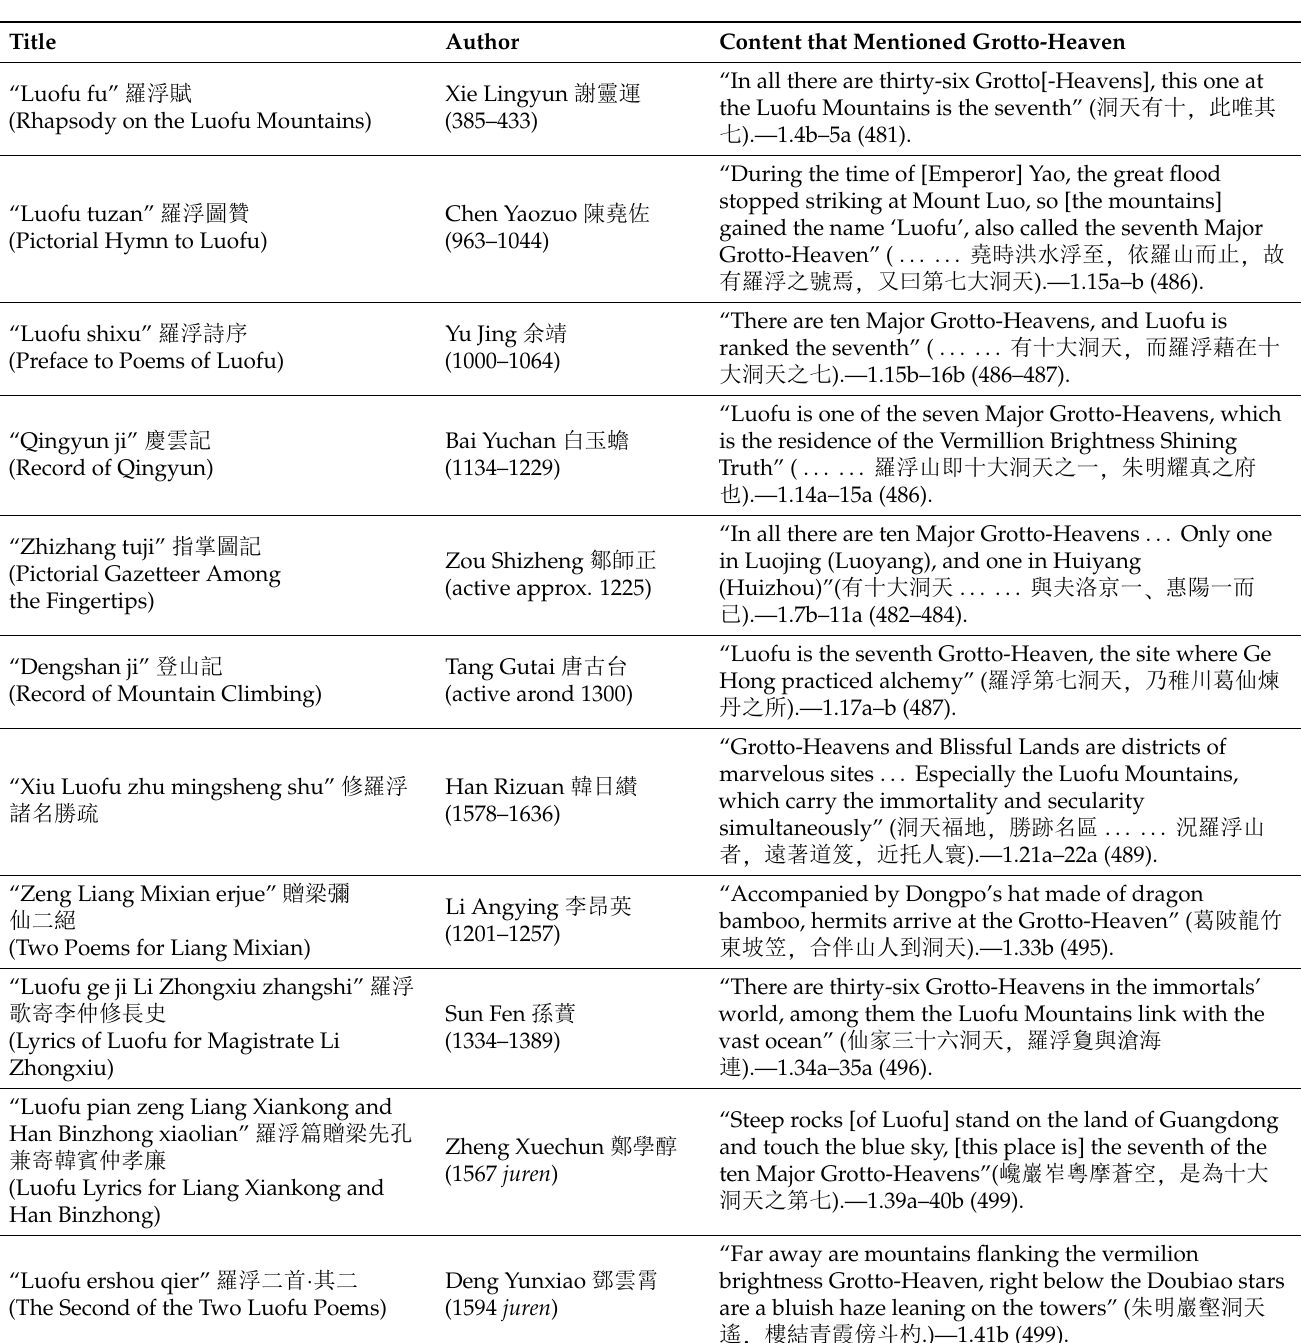
Table 1. Poems Describing Luofu as a Grotto-Heaven Collected in Luofu Yesheng